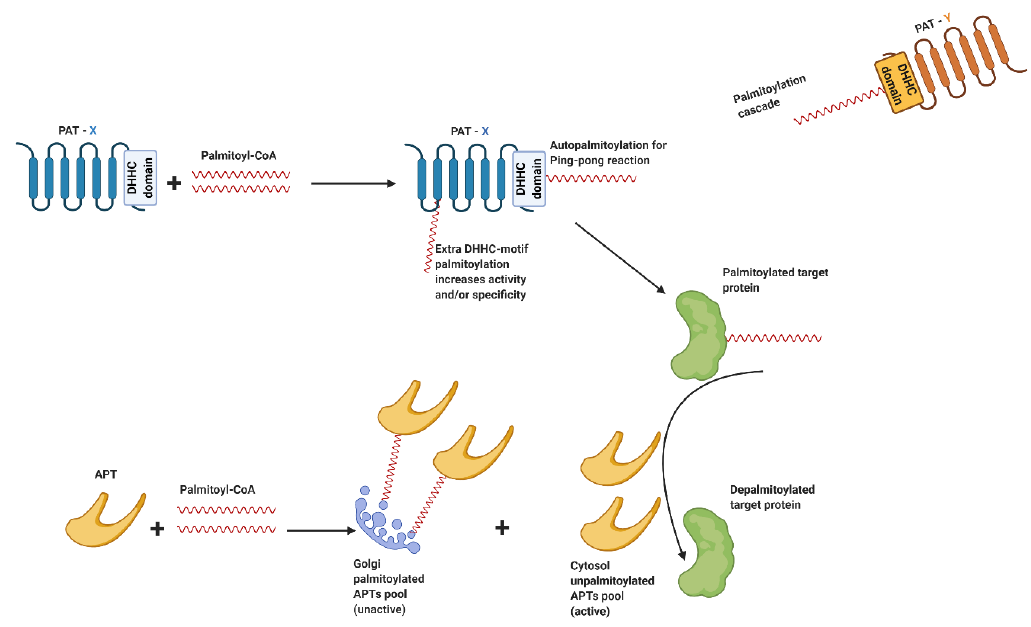
Figure 3. Model of regulation of PATs and APTs. Upper part : palmitoyl acyltransferase-X (PAT-X in blue) attacks palmitoyl-CoA and performs autopalmitoylation within the DHHC domain to form the acyl-intermediate of the so-called ping-pong reaction. Palmitate is then transferred to protein cysteines. Besides palmitoylation within the DHHC motif, S-acylation of PAT can also occur in other regions of the enzyme (extra DHHC-motif palmitoylation), presumably as a mechanism to increase PATs activity and / or specificity. In addition, (auto)palmitoylation of PATs may be mediated by other PATs (PAT-Y in orange) in a reaction identified as palmitoylation cascade. Bottom part : When palmitoylated, acyl protein thioesterase (APT in light orange) is anchored to the Golgi, forming the Golgi unactive APT pool. In contrast, the unpalmitoylated cytoplasmic pool of APTs is active and performs depalmitoylation of target proteins.